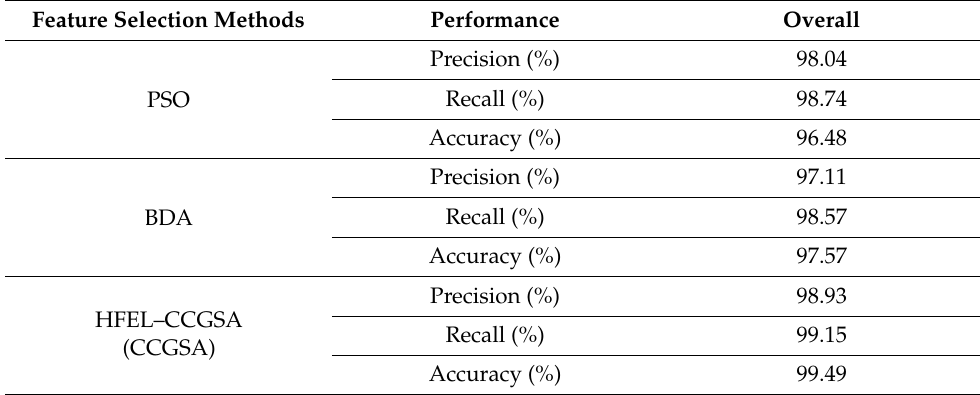
Table 9. Performance analysis for different feature selection methods and HFEL–CCGSA on Eurosat